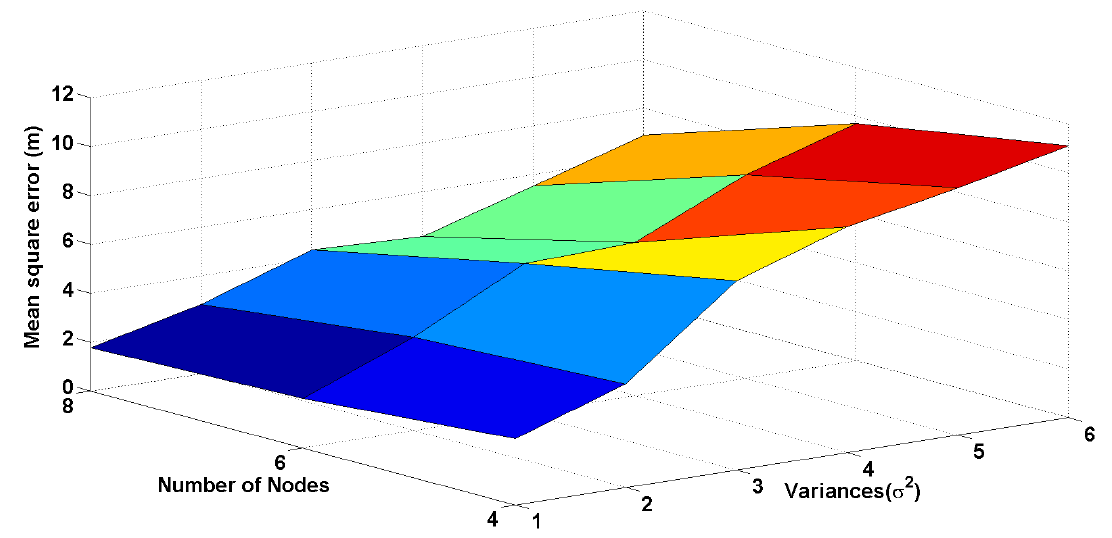
Figure 8. Variance vs. mean square error